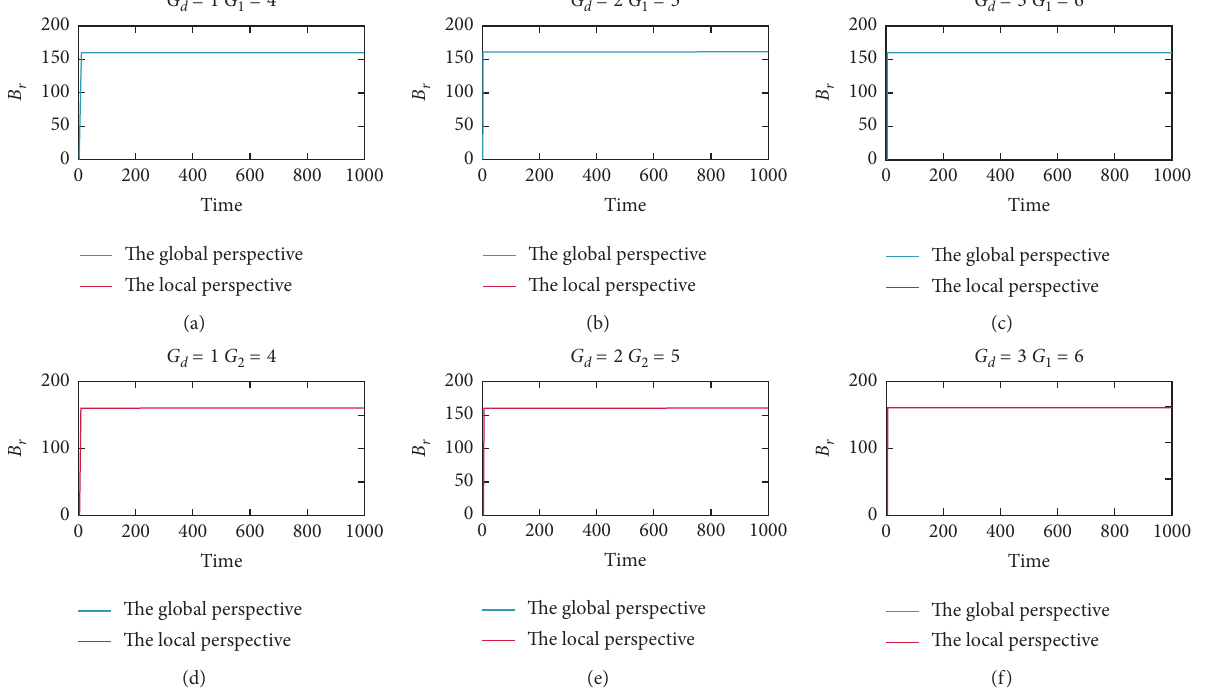
Figure 21: The initial inventory changes of the retailer in a stable state under the scenario of random demand obeying uniform distribution from different